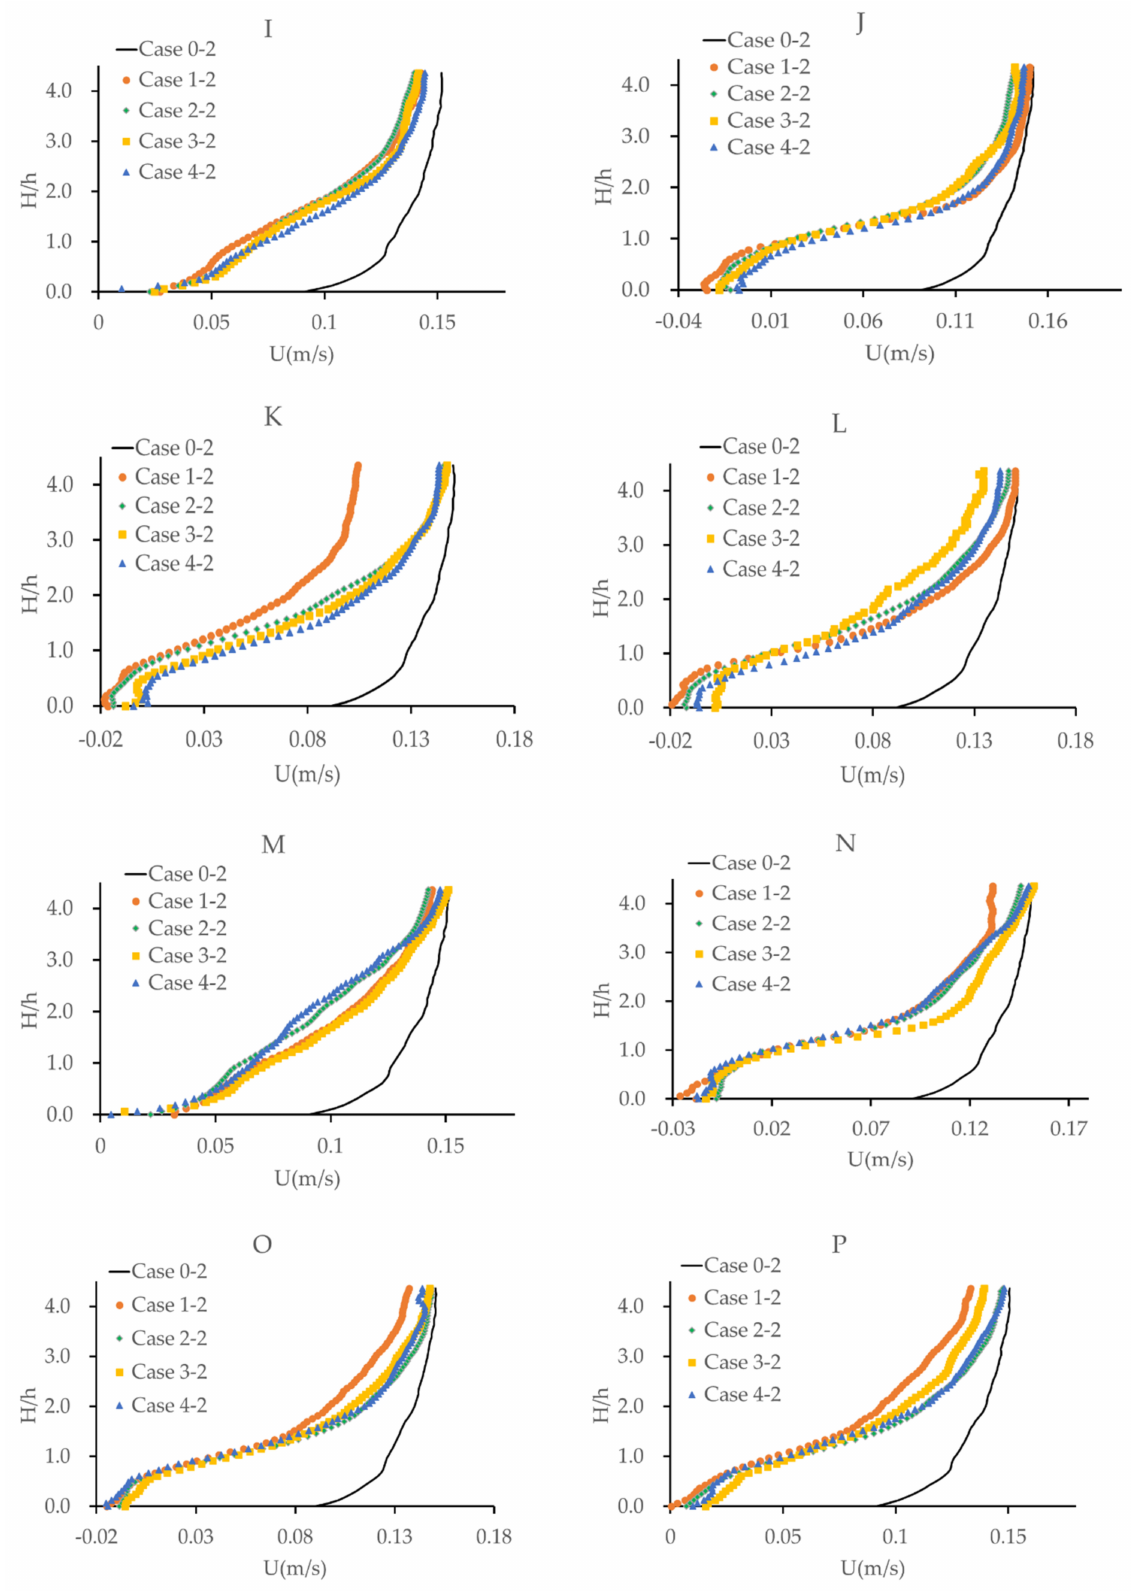
Figure 6. Longitudinal velocity distribution of each section of M-shaped unit